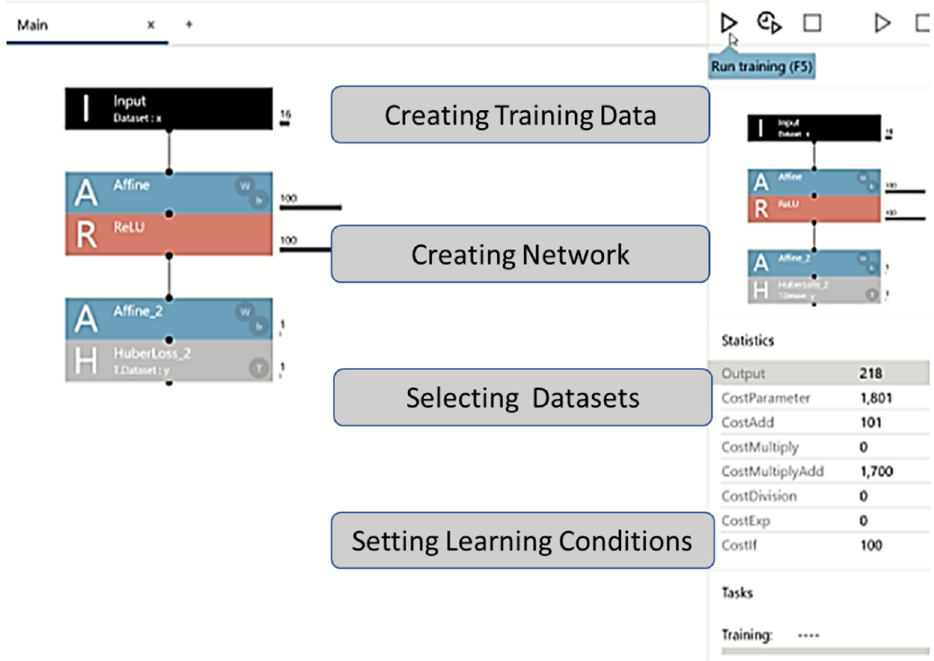
Figure 1. Graphical user interface of the machine learning framework. The figure explains the experimental process with the Neural Network Console. Learning progress and learning results screens are shown. After setting the parameters, one can set the training conditions, the number of epochs (Max Epoch), and batch size (Batch Size) in the Global Config on the CONFIG tab. In the project screen of the NNC, a one-layer neural network (Input, Affine, Rectified Linear Unit (ReLU), and Affine2) was created by adding functions to the network graph, starting with Input in components. Thereafter, we checked if the CSV file of the dataset could be read.